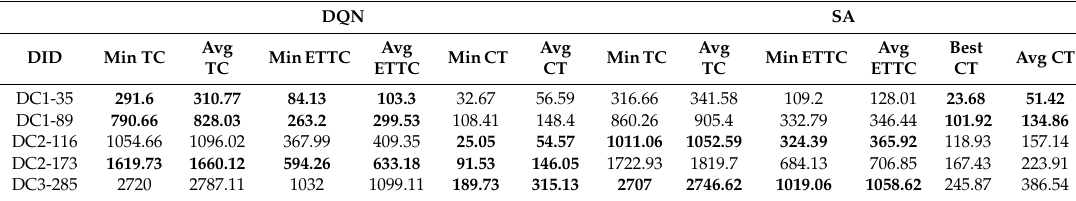
Table 8. Performance comparison between DQN and